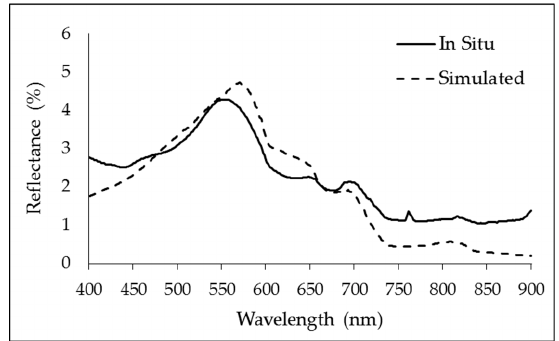
Figure 9. The mean simulated and observed reflectance using three stations in September 2016.